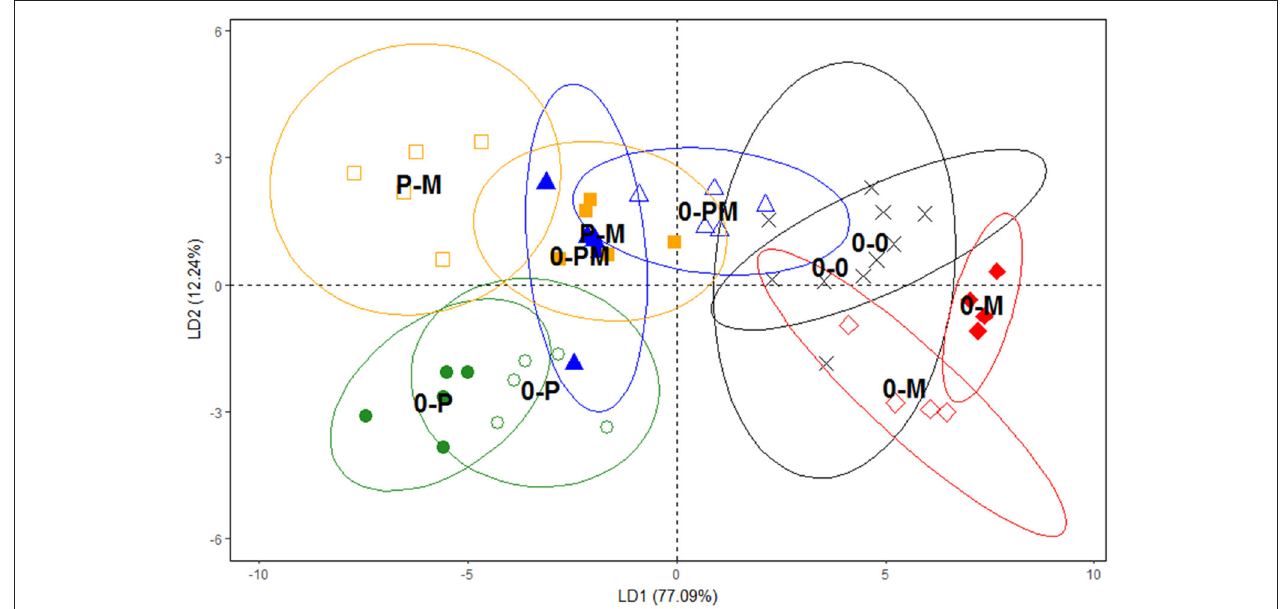
FIGURE 4 | Separation of microbial communities according to PLFA groupings using a discriminant function analysis (DFA). Control plants (0-0, x ), plants treated with protists (0-P treated chamber •, non-treated chamber ◦ ), with mycorrhiza (0-M treated chamber (cid:7) , non-treated chamber ♦ ), with both protists and mycorrhiza together (0-PM, treated chamber N , non-treated chamber 1 ), or where the left and right root chambers were separately treated with protists and mycorrhiza (P-M, protists (cid:3) , mycorrhiza (cid:4) ). Ellipses represent confidence ranges of 95%. Variation explained by axes 1 and 2 in parentheses.